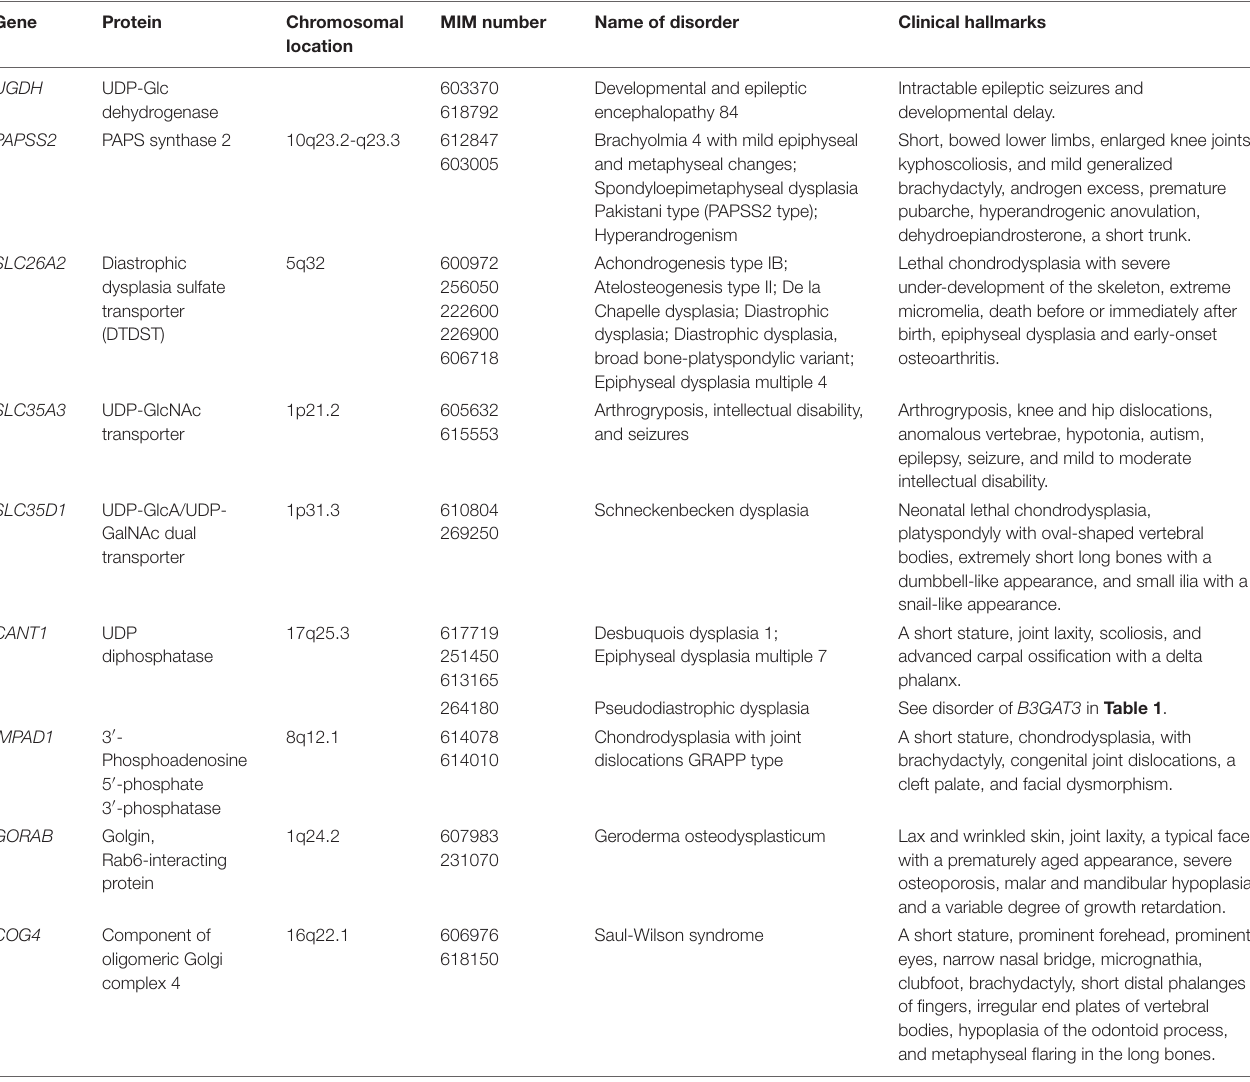
TABLE 5 | Congenital disorders of UDP-sugars, PAPS, and related protein